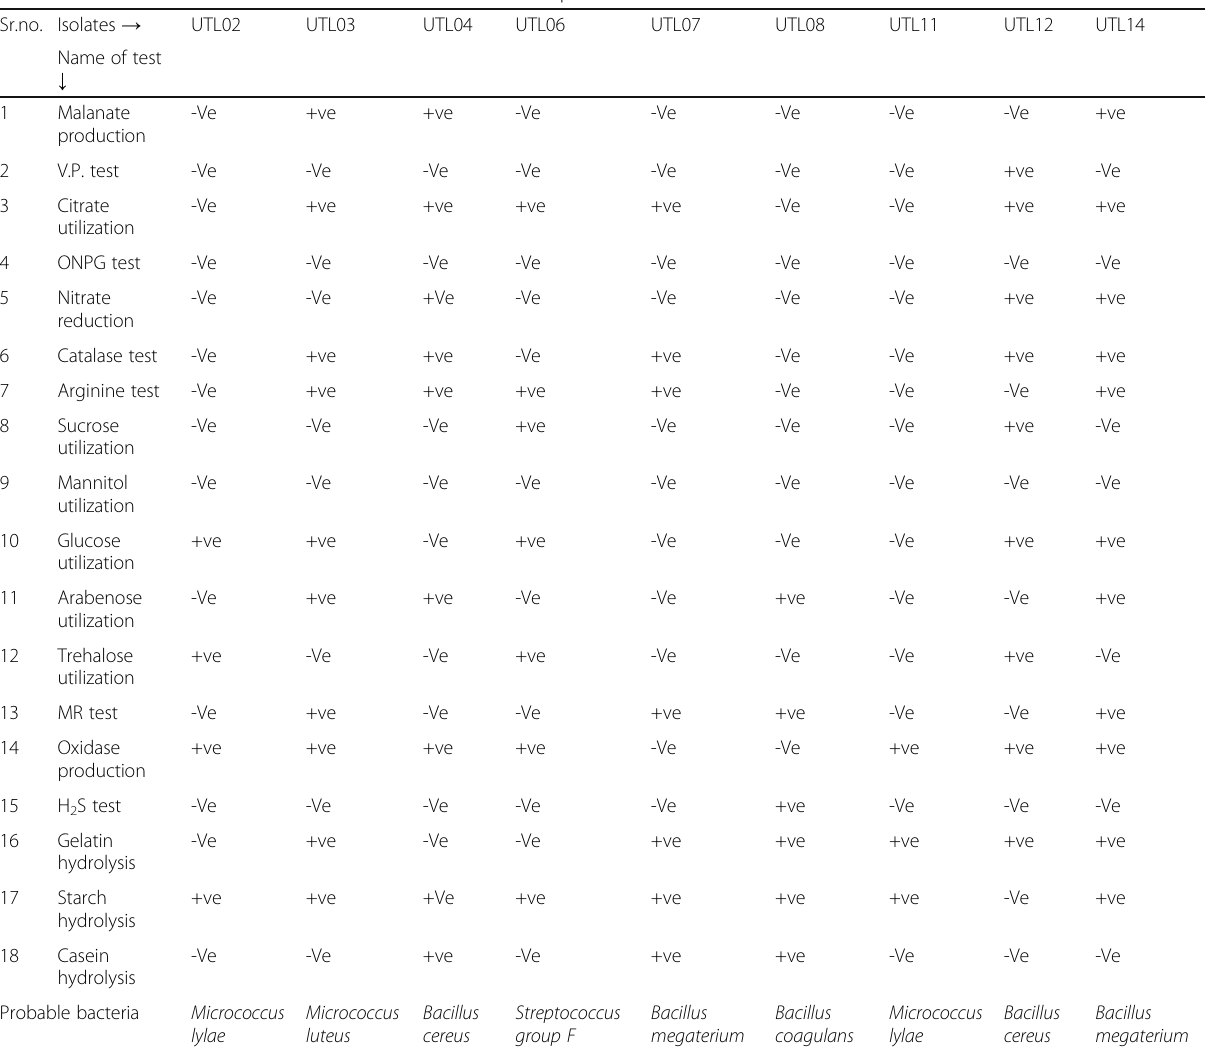
Table 5 Biochemical characterizations of unused leech Gram-positive isolates Sr.no. Isolates